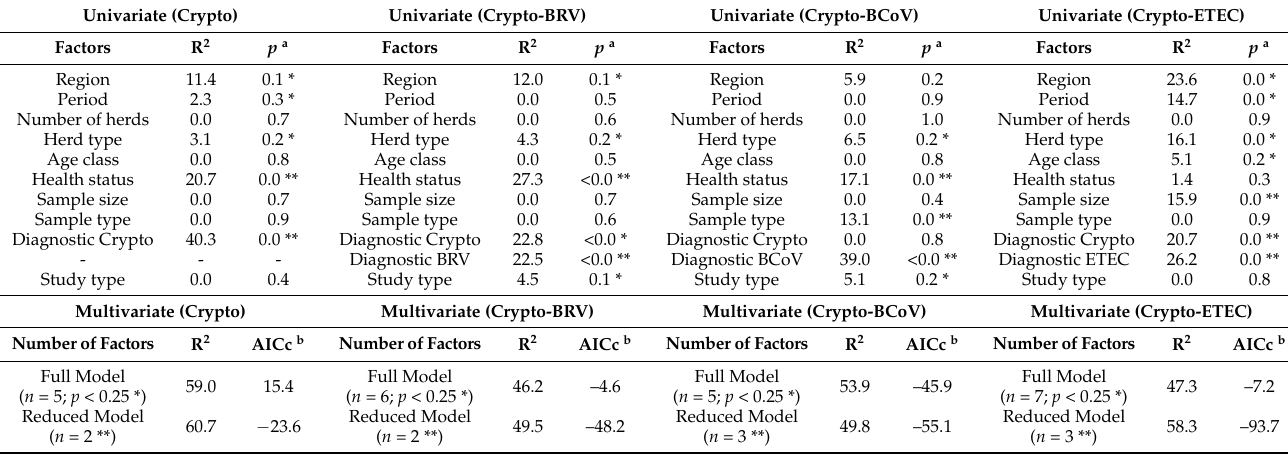
Table 1. Uni- and multivariate meta-regression analysis stratified by different types of Crypto infection and potential influencing